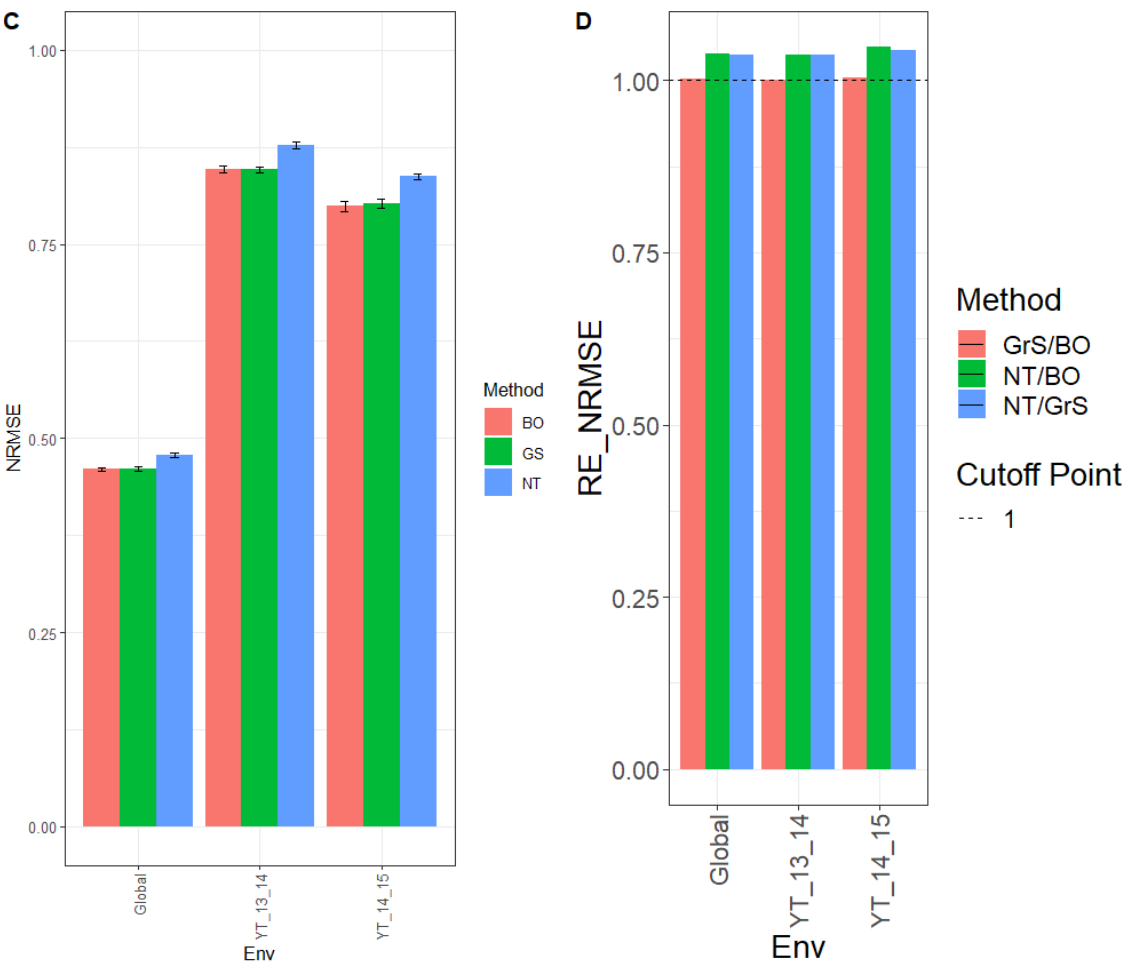
Figure 1. Dataset 1 (Wheat 1). A ) Mean squared error (MSE) and the corresponding standard error (SE) of the methods: Bayesian optimization (BO), grid search optimization (GrS), and no tuning (NT) for each environ- ment and across environments of dataset 1. B ) Relative efficiency in terms of the mean squared error (RE_MSE) computed by dividing the MSE of NT and BO; NT and GrS; or GrS and BO. Prediction performance is reported for each environment and across environments in the dataset 1. When RE_MSE>1, the denominator method outperforms the numerator in terms of prediction performance. C ) Normalized root mean square error (NRMSE) and the corresponding standard error (SE) of the methods Bayesian optimization (BO), grid search optimization (GrS), and no tuning (NT) for each environment and across environments of dataset 1. D ) Rela- tive efficiency in terms of the normalized mean squared error (RE_NRMSE) computed by dividing the NRMSE of NT and BO; NT and GrS; or GrS and BO. Prediction performance is reported for each environment and across environments in dataset 1. When RE_NRMSE>1 the denominator method outperforms the numerator in terms of prediction